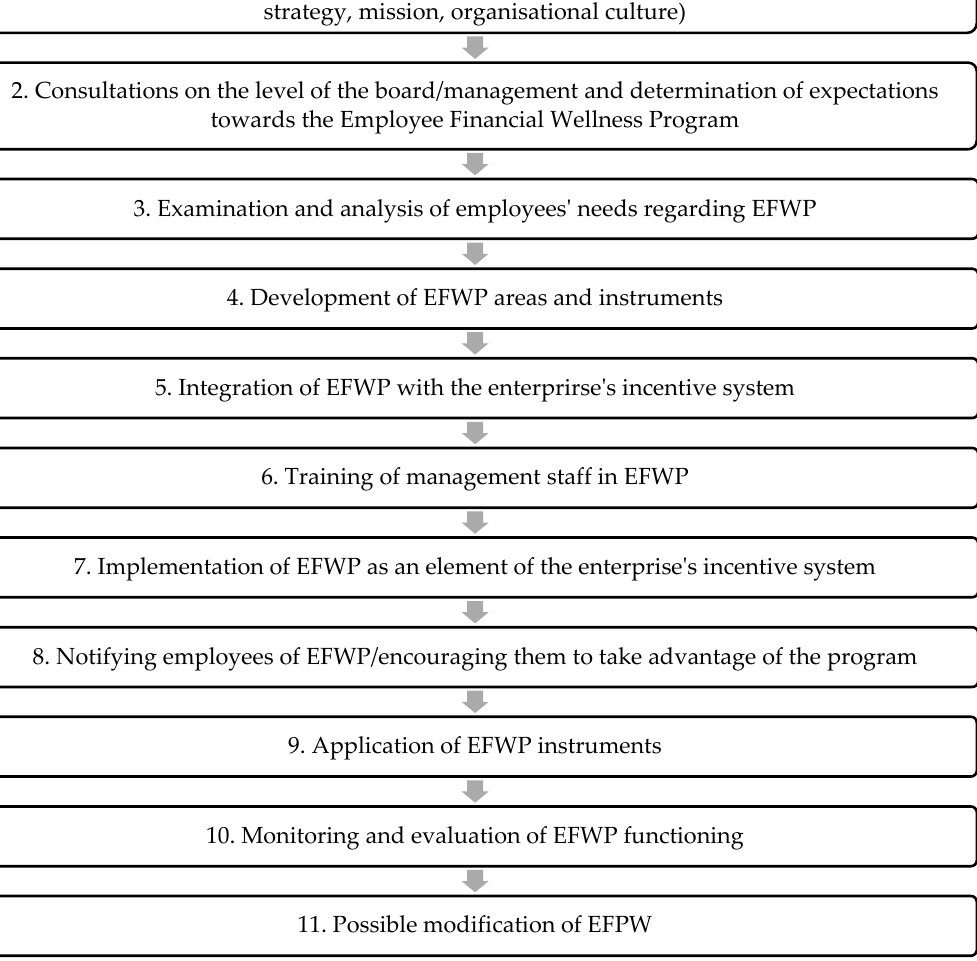
Figure 2. Stages of constructing an Employee Financial Wellness Program at an enterprise. Source: Own study.